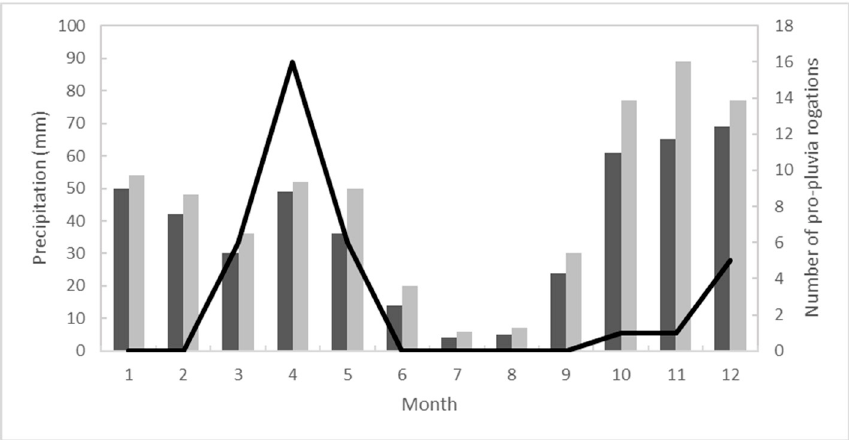
Figure 2. The mean monthly precipitation of Badajoz (dark grey vertical bars) for the period 1981 − 2010 and Cáceres (light grey vertical bars) for the period 1982 − 2010. Black line shows the number of pro- pluvia rogations celebrated in Extremadura region in the period 1824 − 1931.